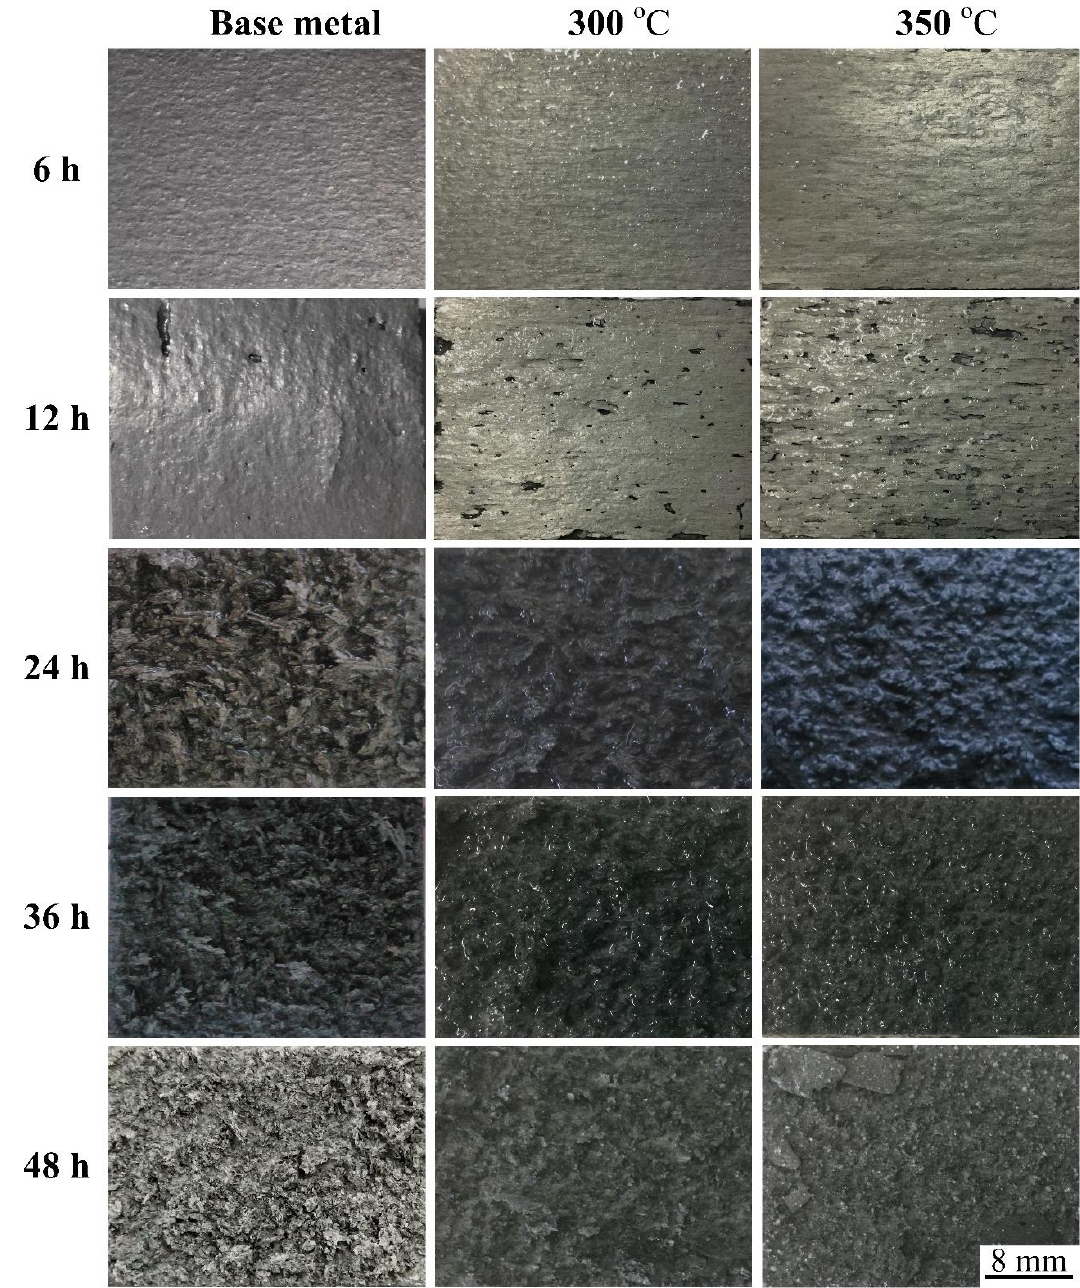
Figure 7. Surface evolution of all samples after exfoliation corrosion at different time periods. Table 2. Evolution of exfoliation corrosion grade with immersion times for 7N01 aluminum alloy in different conditions.